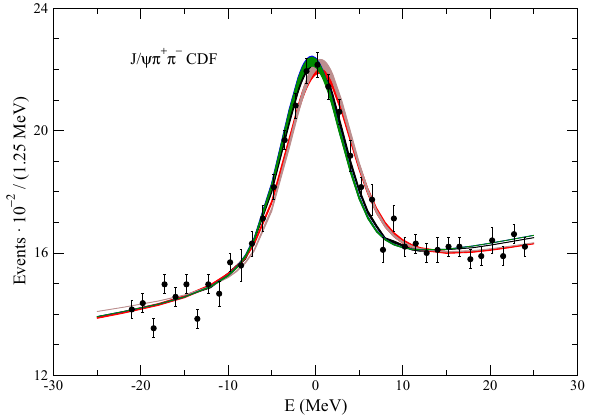
Fig. 9 The curves of the different cases for the J /ψπ + π − event dis- tribution from the inclusive p ¯ p scattering [18] are given with error bands included. The black -, red -, brown -, blue -, and green-filled bands correspond to cases 1, 2.I, 2.II, 3.I and 3.II, in